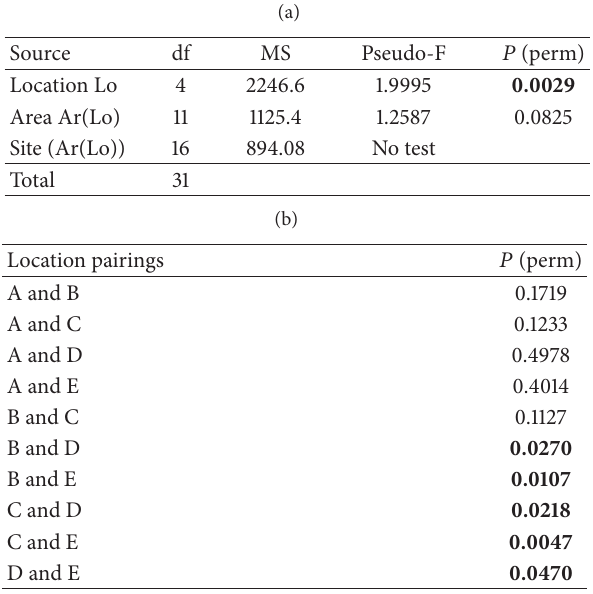
Table 1: (a) PERMANOVA to compare the assemblage composition of the abundant/encrusting fauna based on Bray Curtis similarities. Data were dispersion weighted and square root transformed. (b) Pairwise tests for Location differences. 𝑃 values in bold type are